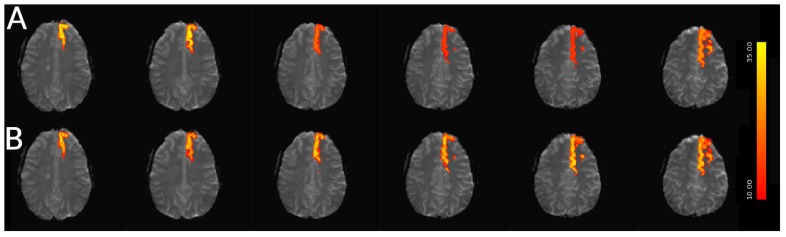
Spatial map of functionally connected regions with and without STC on simulated data. The left Superior Frontal region is extracted using ICA on both STC data and uncorrected data. The ICA from each dataset is then regressed back on the original data for (A) uncorrected and (B) FSL STC data. In the left-most slices, regression z-statistics are higher in the uncorrected data, however, overall the STC data best describes the variance in the entire region, as seen by the drop in z-statistics in slices 3–5 in uncorrected data, while the STC data’s z-statistics remain high across all slices.